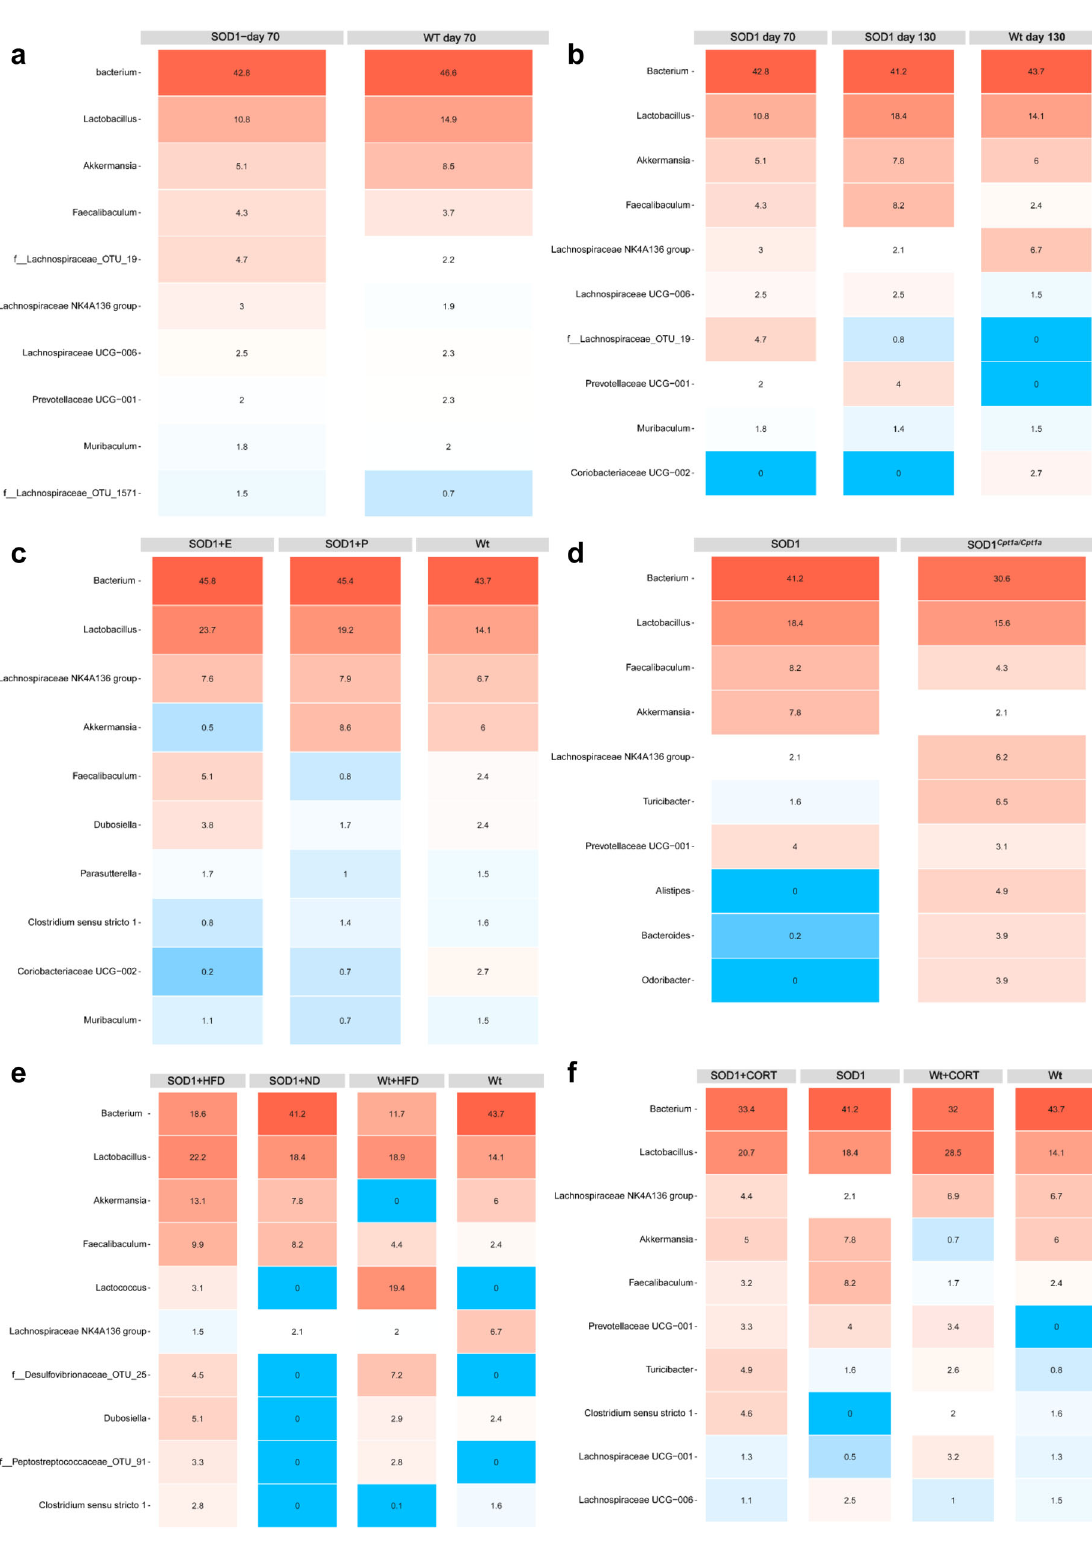
barrier facility at Aalborg University with a room temperature of 21 °C. The mice were kept at a 12-hour light/dark cycle and had ad libitum access to food and water. Sample size was estimated based on previous studies and a pilot study described in the manuscript. genic SOD1 mice were maintained in our animal facility by crossing hemizygote